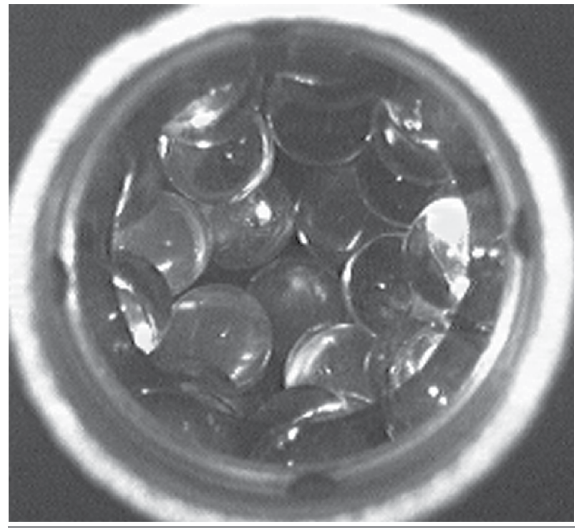
Figure 24. Small footprint area chips used in later versions of 1 st generation, blue dental light curing